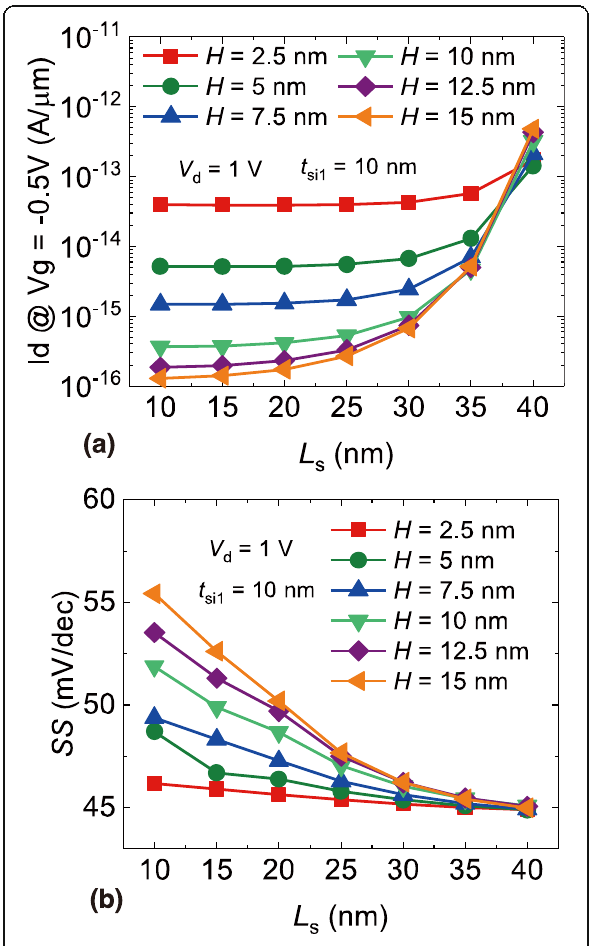
Fig. 7 a The ambipolar current and b the subthreshold slope of the SC TFET as a function of the L S with various